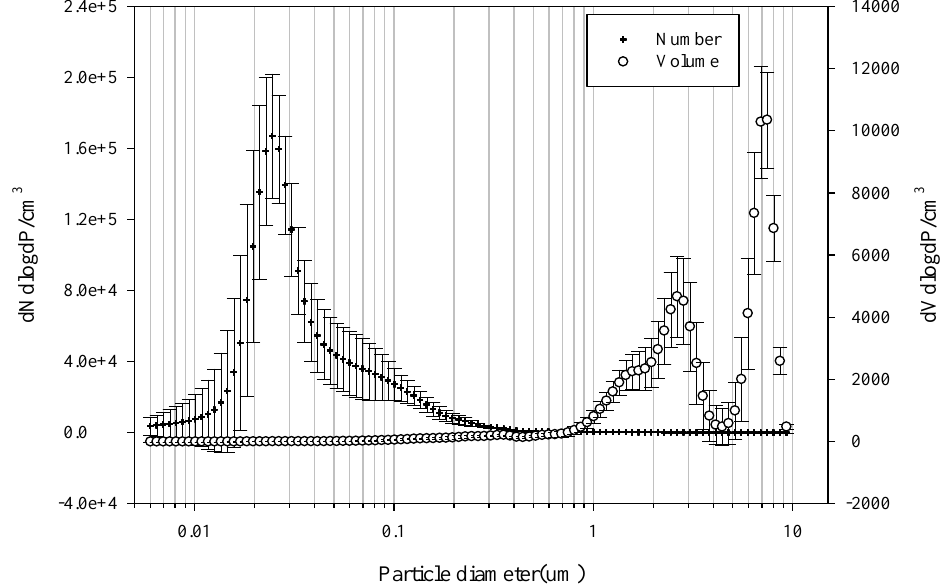
Figure 6. Size distribution of PM in the subway tunnel at the M station between 7:00 and 8:00 p.m. on 15 May 2017.